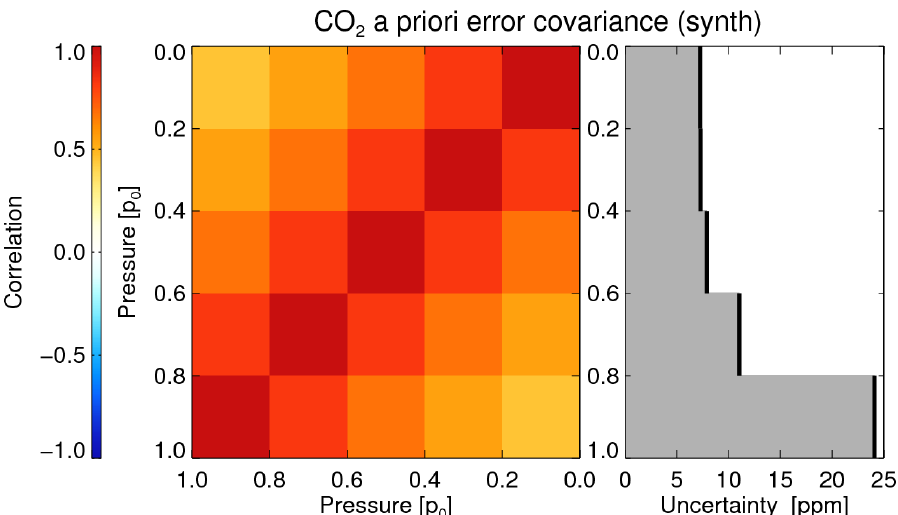
Figure 11. As Figure4 but for a synthetic a priori error covariance matrix as proposed by Reuter et al. [30] but with a correlation length of 1.0 p 0 .